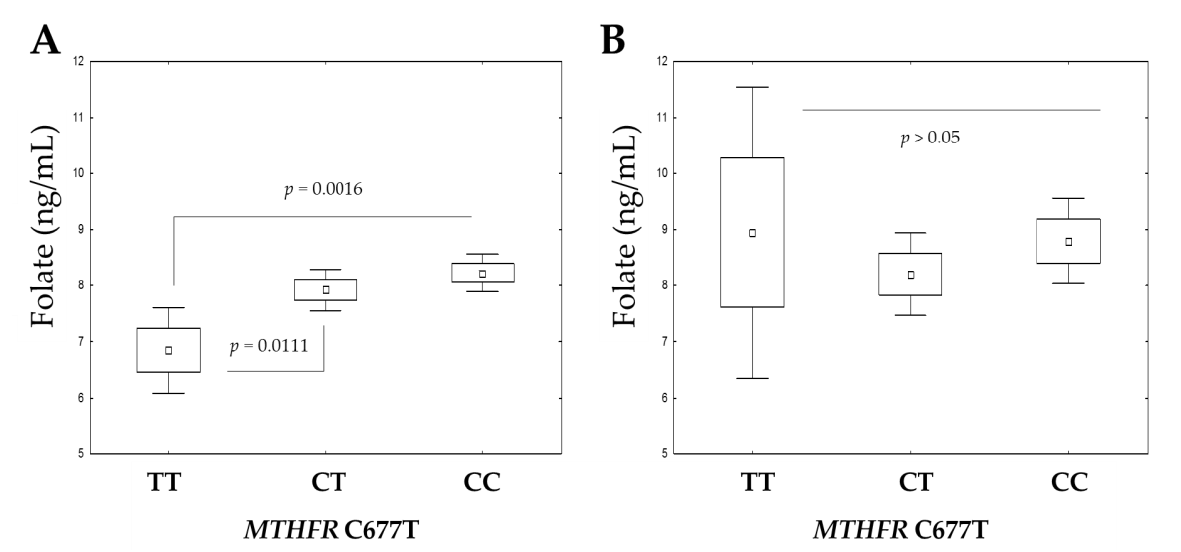
Figure 2. The serum folate concentrations at baseline ( A ) and after body-weight reduction ( B ) ac- cording to MTHFR C677T genotype . The boxplots show the mean, SE (standard error) and 1.96 × SE. ANOVA with Tukey’s multiple comparisons test was performed.